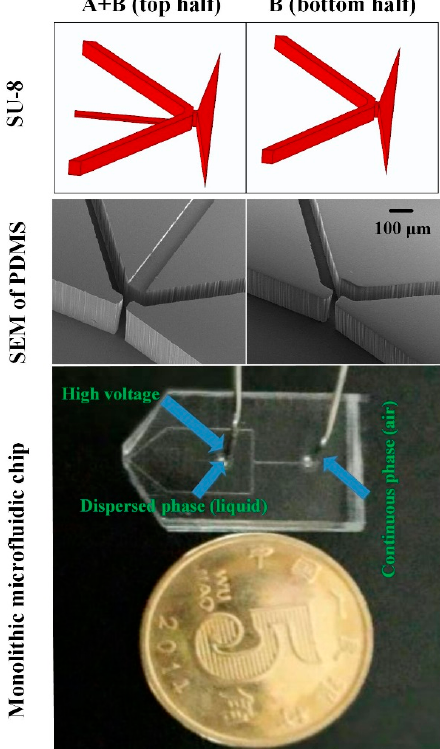
Figure 2. ( Top )Top and bottom SU-8 master molds; ( Middle ) Top and bottom structures of PDMS under SEM; ( Bottom ) monolithic microfluidic chip. under SEM; ( Bottom ) monolithic microfluidic